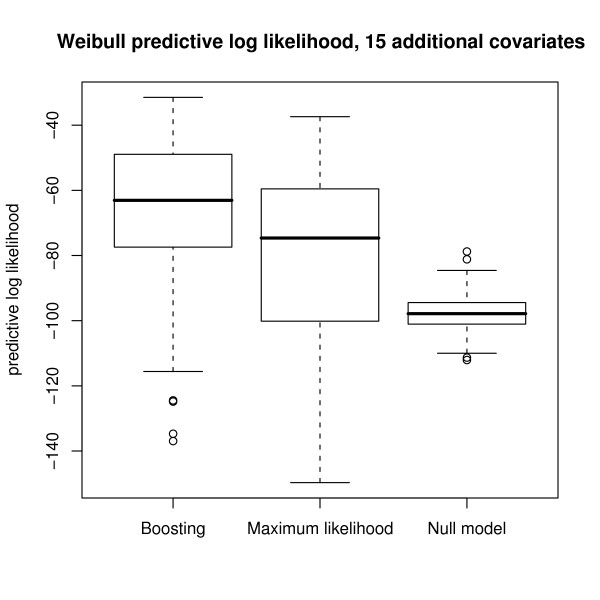
Boxplots of the predictive Weibull log likelihood estimates. Boxplots of the predictive Weibull log likelihood estimates, as obtained from the 50 Weibull-distributed test samples following Model (10). The predictive log likelihood values of the null model were obtained via maximum likelihood estimation with no covariates and an intercept only. Similar results were obtained for the log-logistic and lognormal models.